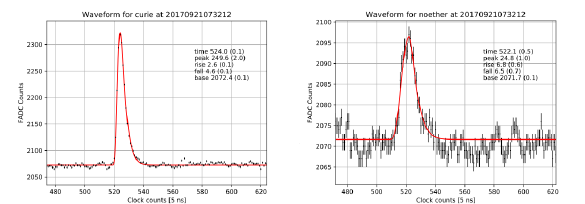
Figure 7. The signal waveforms for two counters in the event from Figure 6: curie and